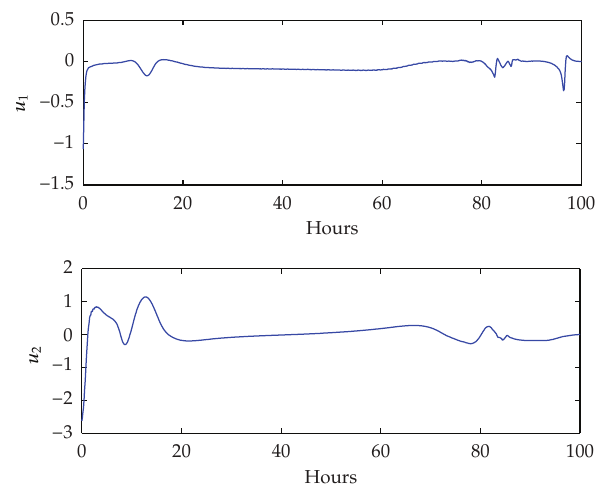
Figure 4: The optimal control graph for the two controls, namely, immune boosting and pathogen sup- pressing